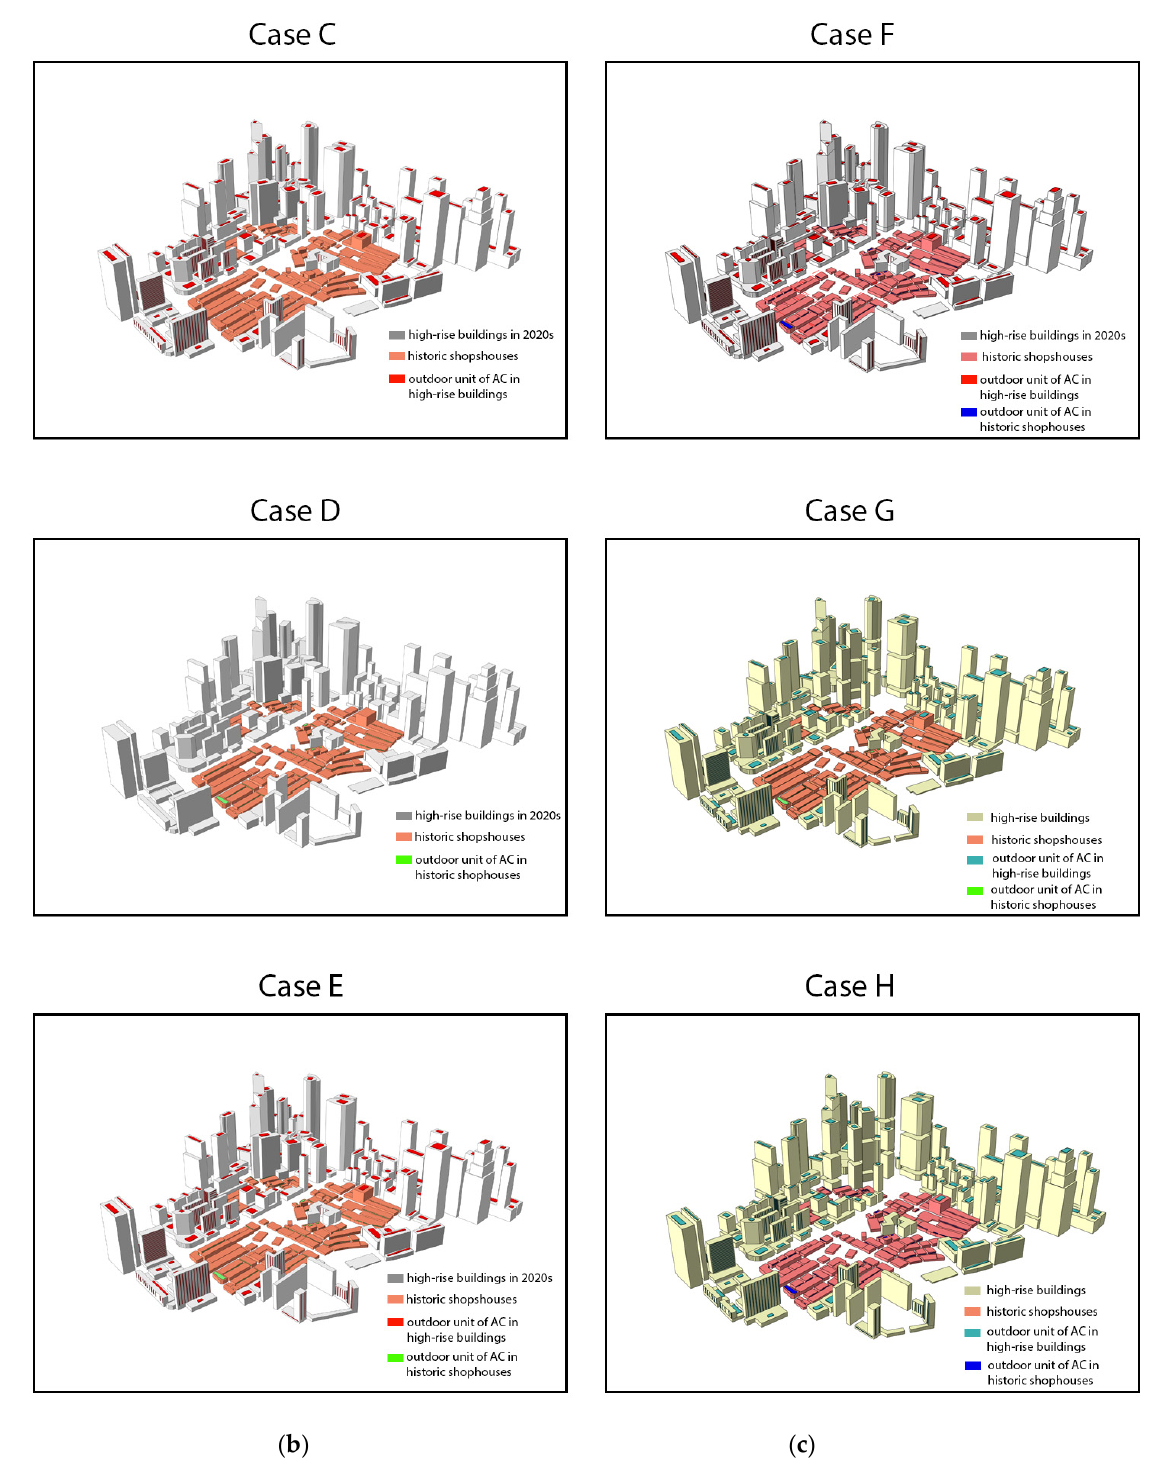
Figure 2. ( a ) Simulation scenarios of Case A and B to represent the urban geometry in the past (1960s) and the current (2020s). ( b ) ( Left ) Simulation scenarios of Case C–E to represent the impact of anthropogenic heat emitted from high-rise buildings, historic shophouses, and both. ( c ) ( Right ) Simulation scenarios of Case F–H to represent the developed mitigation strategies focusing on the historic shophouses, high-rise buildings, and both.